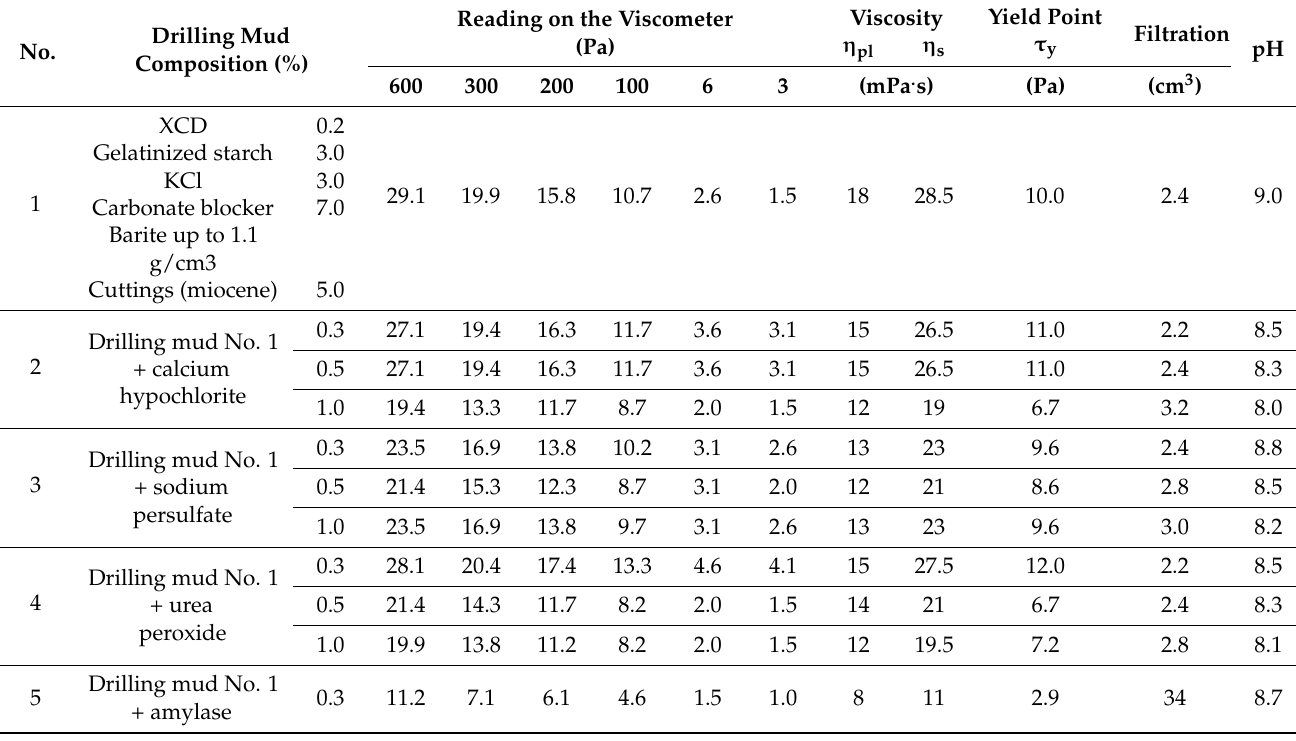
Table 1. The properties of potassium-polymer drilling mud A with the addition of oxidizing agents and amylase.